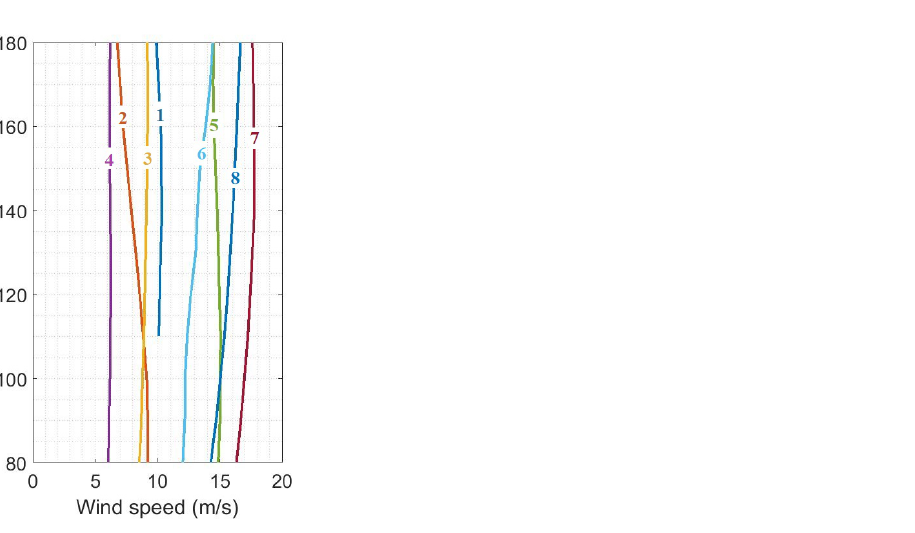
Figure 4. Height profiles of the mean wind speed for eight Bora wind episodes, marked by their ordinal